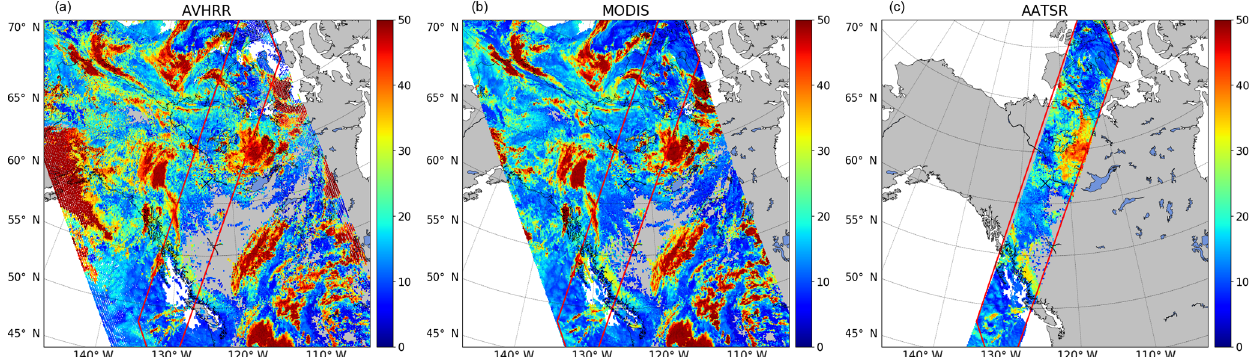
Figure 5. CER retrieval values for study area NA2 with data from AVHRR (a) , MODIS (b) , and AATSR (c) .